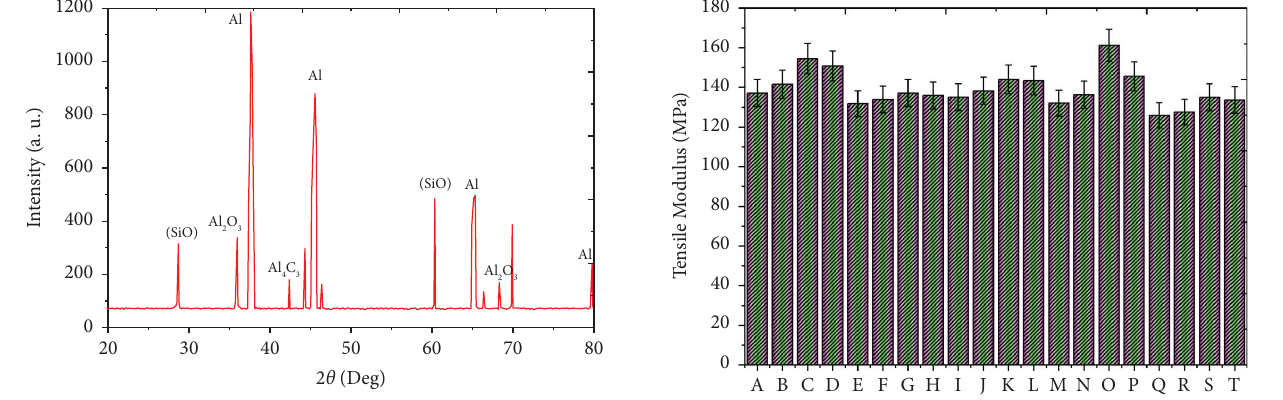
2 O 3 Figure 5: Tensile modulus of biosynthesised Al epoxy hybrid